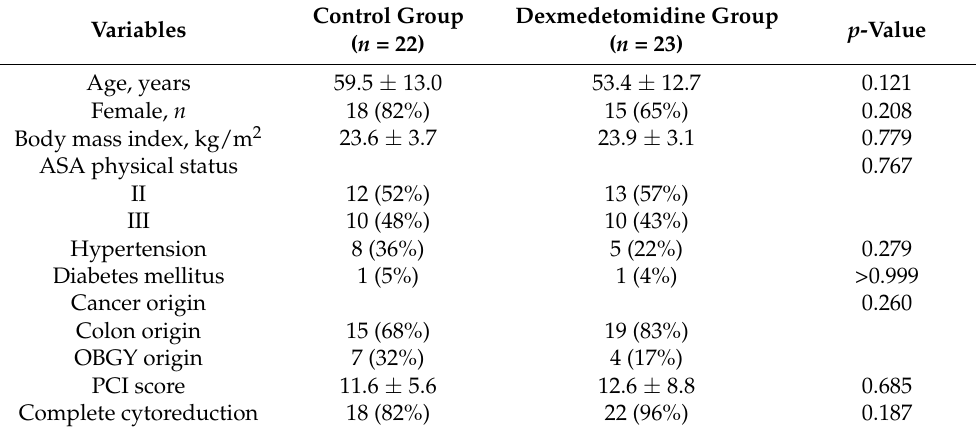
Table 1. Demographic and preoperative characteristics.